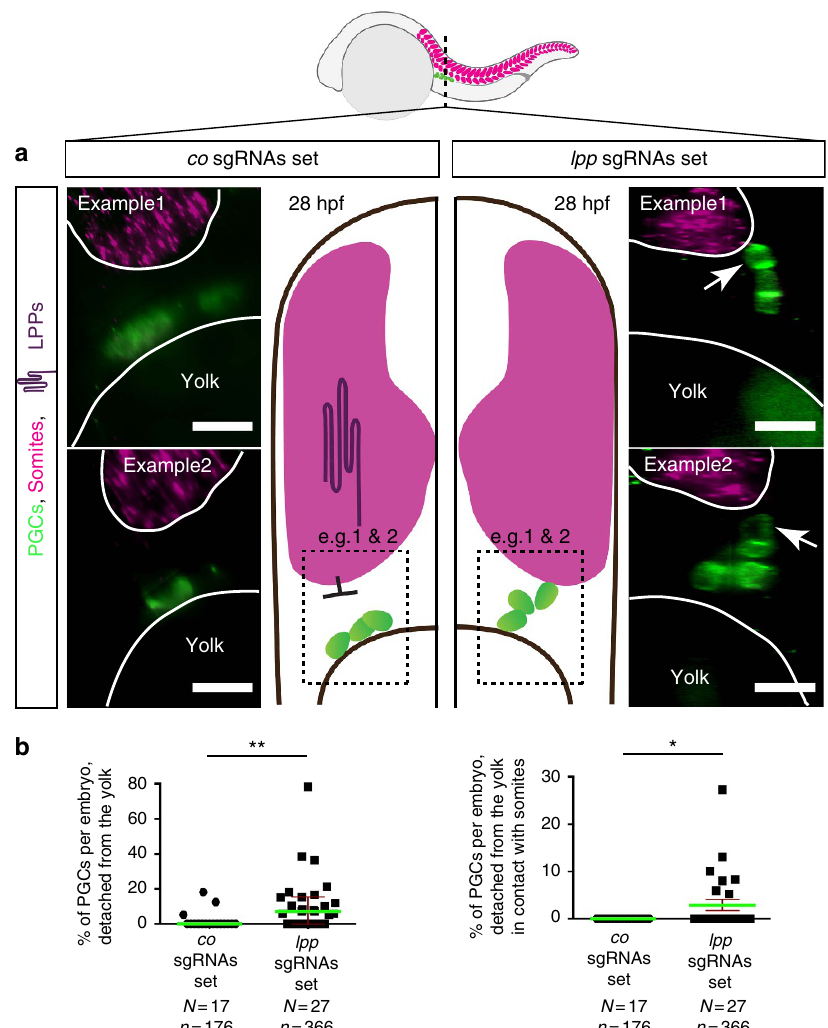
Figure 3 | Abnormal positioning of PGCs in embryos treated with Cas9 and sgRNAs set against lpp s. ( a ) Optical cross-sections (plane marked by dashed line in the embryo scheme) of whole-mount 28hpf embryos ( Tg(kop:egfp-f-3 0 nos3 ) expressing EGFP in their PGCs following RNAscope procedure labelling myoD expression in somites (magenta, border marked in white). In contrast with control embryos (left panels), in embryos treated with Cas9 and a set of sgRNAs targeting 6 lpp s (right panels) PGCs detach from the yolk and can contact somites (arrows). Scale bars, 20 m m. Dorsal is up. ( b ) The percentages of PGCs per embryo detached from the yolk (left graph) and percentage of those in contact with the somites (right graph) is significantly elevated in LPPs-depleted embryos. The statistical significance was evaluated using the Mann–Whitney U -test (* P r 0.05, ** P r 0.01). Green lines signify the mean, error bars the standard error of the mean (s.e.m), N the number of embryos and n the number of PGCs